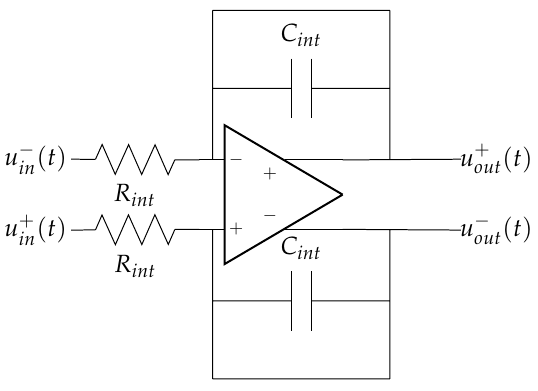
Figure 6. Fully differential analog integrator with reset capability.